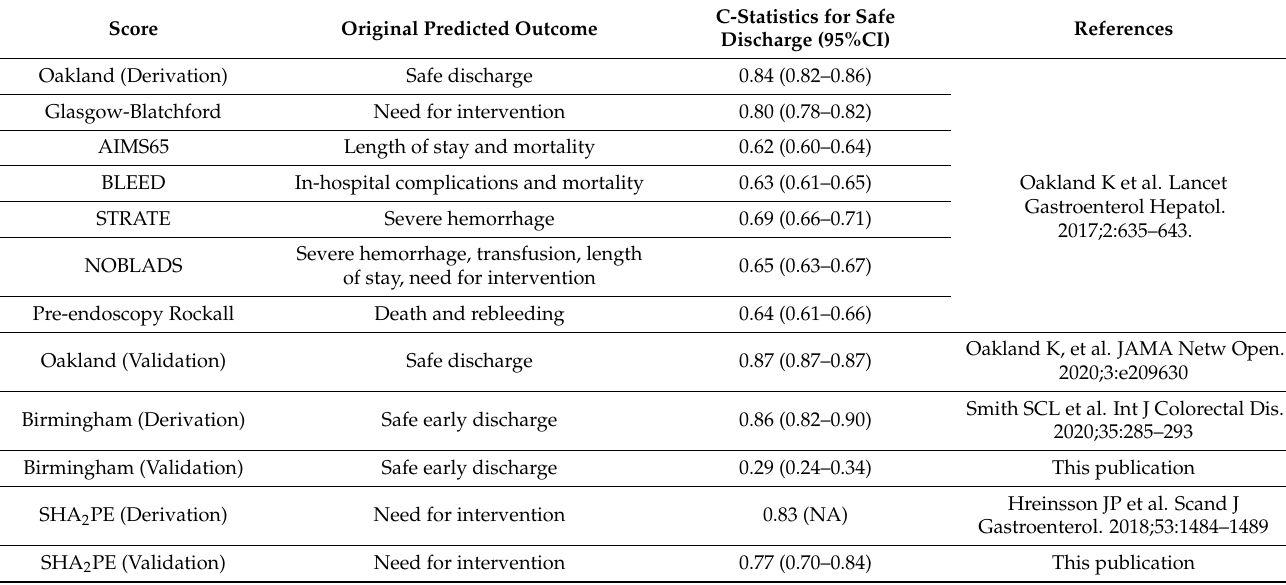
Table A3. C-statistics for the SHA 2 PE compared to previously published models for safe discharge (adapted from ref